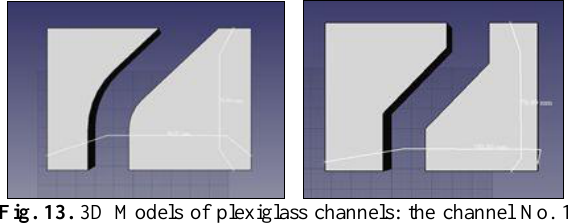
Fig. 13. 3D Models of plexiglass channels: the channel No. 1 (left) and the channel No. 2 (right).